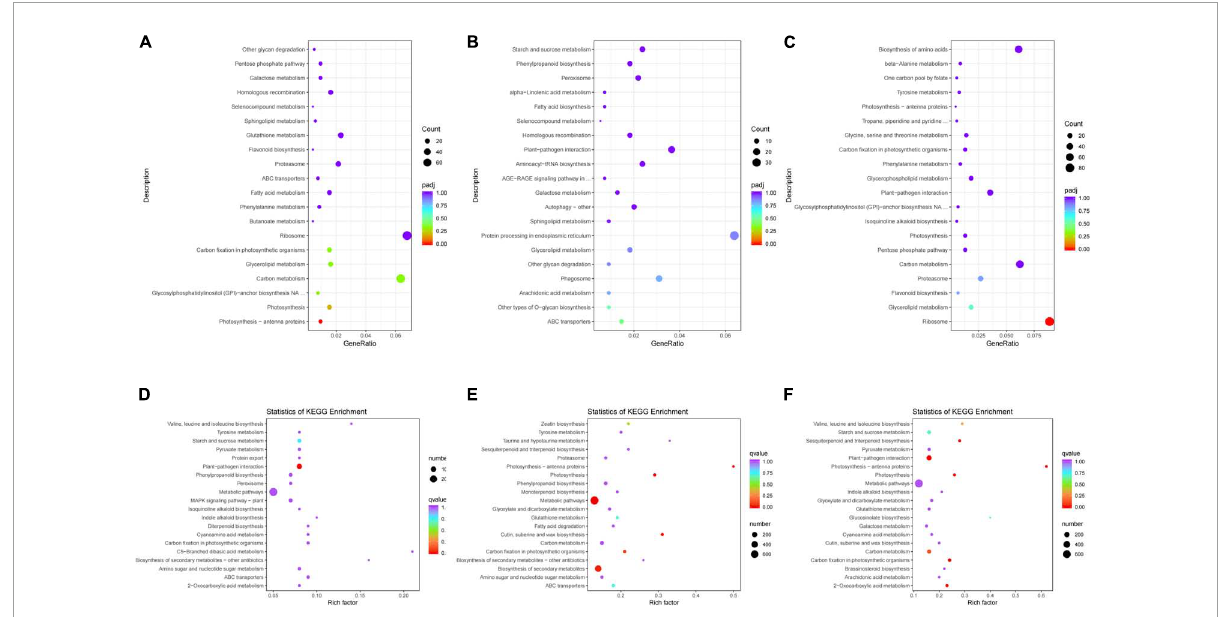
FIGURE4 KEGG pathway enrichment analysis of differentially expressed genes (DEGs) in panels (A–C) group JP and (D–F) group XY. (A) Tea-20 vs. Tea-200, (B) Tea-20 vs. Tea-1200, (C) Tea-200 vs. Tea-1200, (D) Tea-50 vs. Tea-100, (E) Tea-50 vs. Tea-400, and (F) Tea-100 vs.